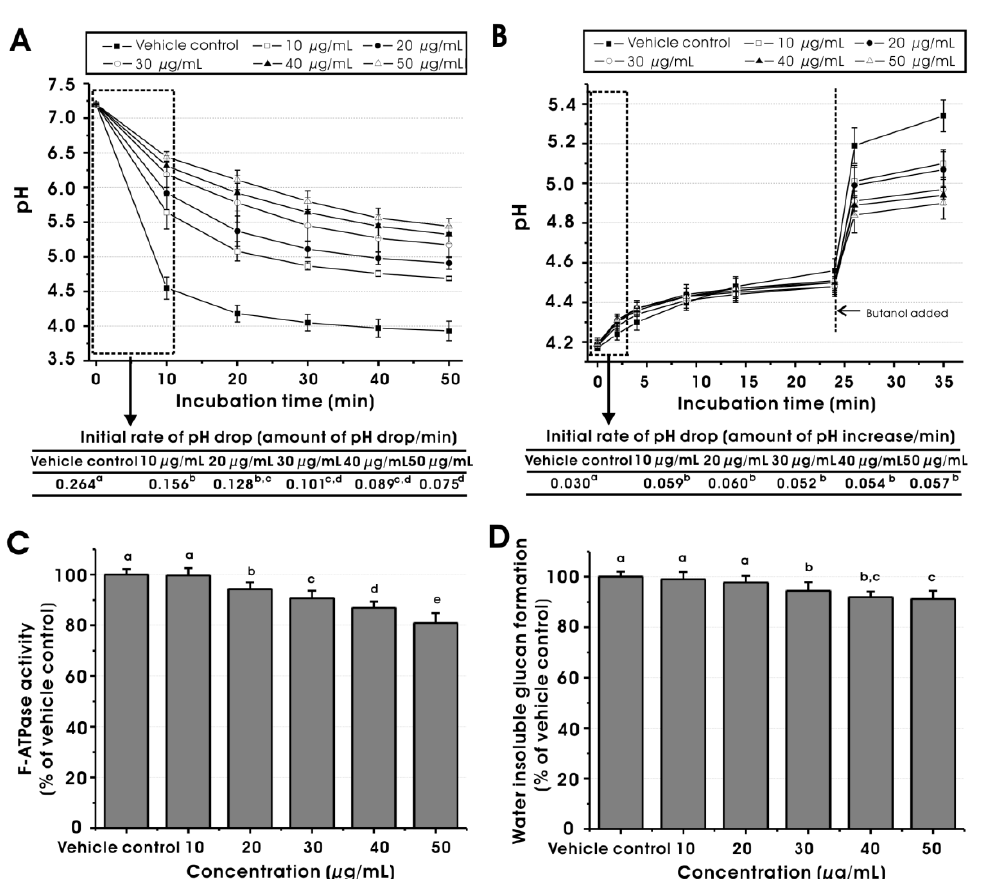
Figure 4. Effects of methanol extract of Dryopteris crassirhizoma root on ( A ) glycolytic pH-drop; ( B ) proton-permeability; ( C ) F-ATPase activity and ( D ) GTF activity of Streptococcus mutans at sub-MIC levels. The data represent mean ± standard deviation. The vehicle control was 1% DMSO. Values followed by the same superscripts are not significantly different from each other ( p >